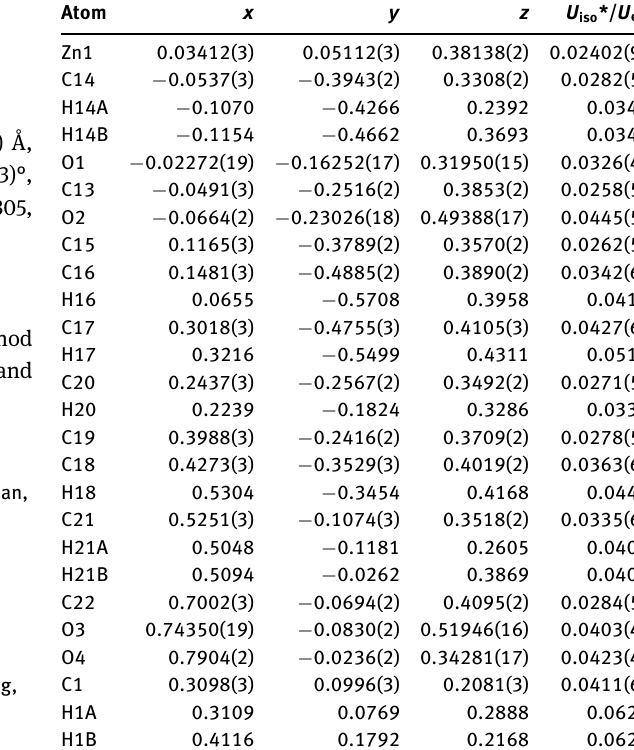
Table 2: Fractional atomic coordinates and isotropic or equivalent isotropic displacement parameters (Å 2